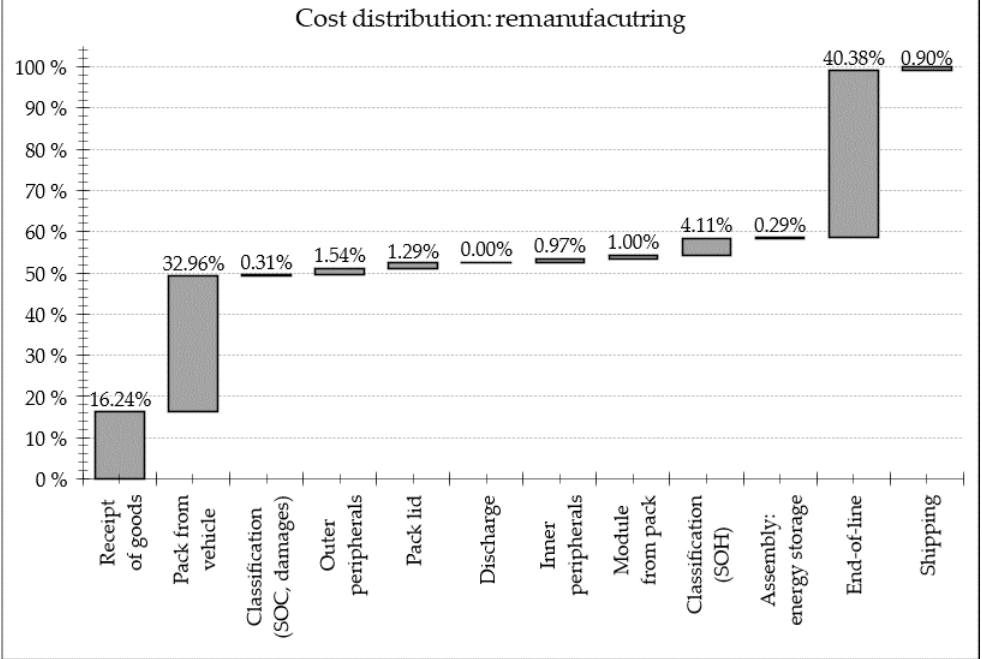
Figure 7. Cost distribution for the repurpose scenario under standard cost assumptions.